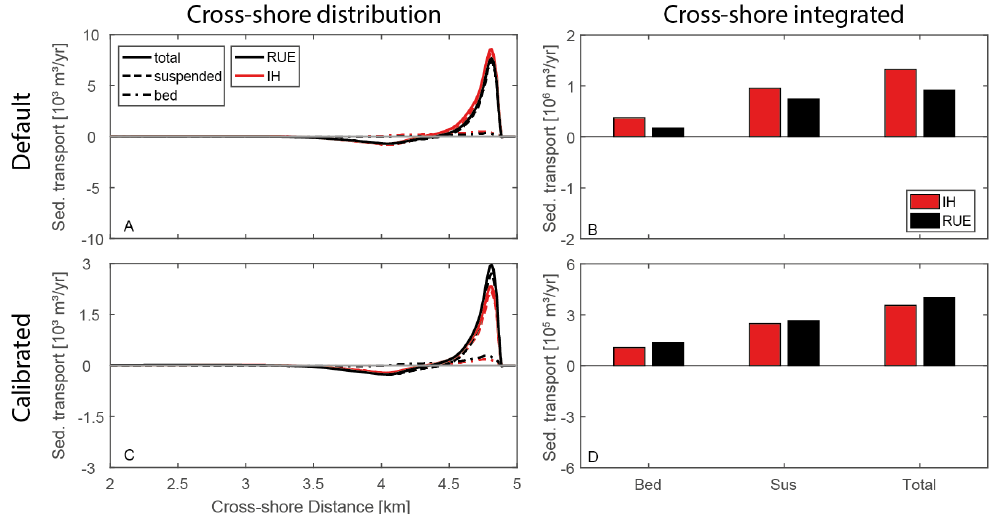
Figure 7. Annual alongshore sediment transport at Katwijk. Positive values are northward. Note different vertical axis scales. ( A , C ) cross-shore profile of net alongshore sediment transport. ( B , D ) Integrated the values in the cross-shore direction. Panels ( A , B ) show default sediment transport values and panels ( B , D ) show calibrated IH and RUE (see Table